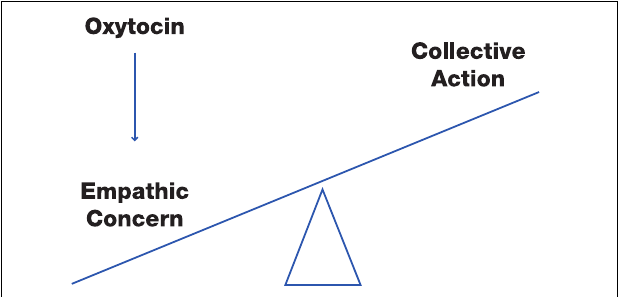
FIGURE 1 | A physiologic model of collective action. Oxytocin induces empathic concern that increases the likelihood of collective